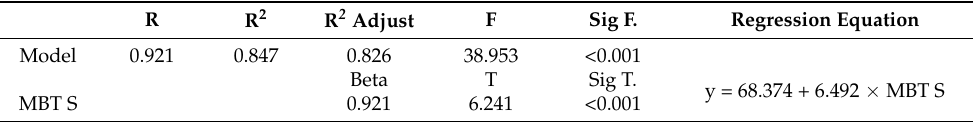
Table 5. Statistics of multiple regression